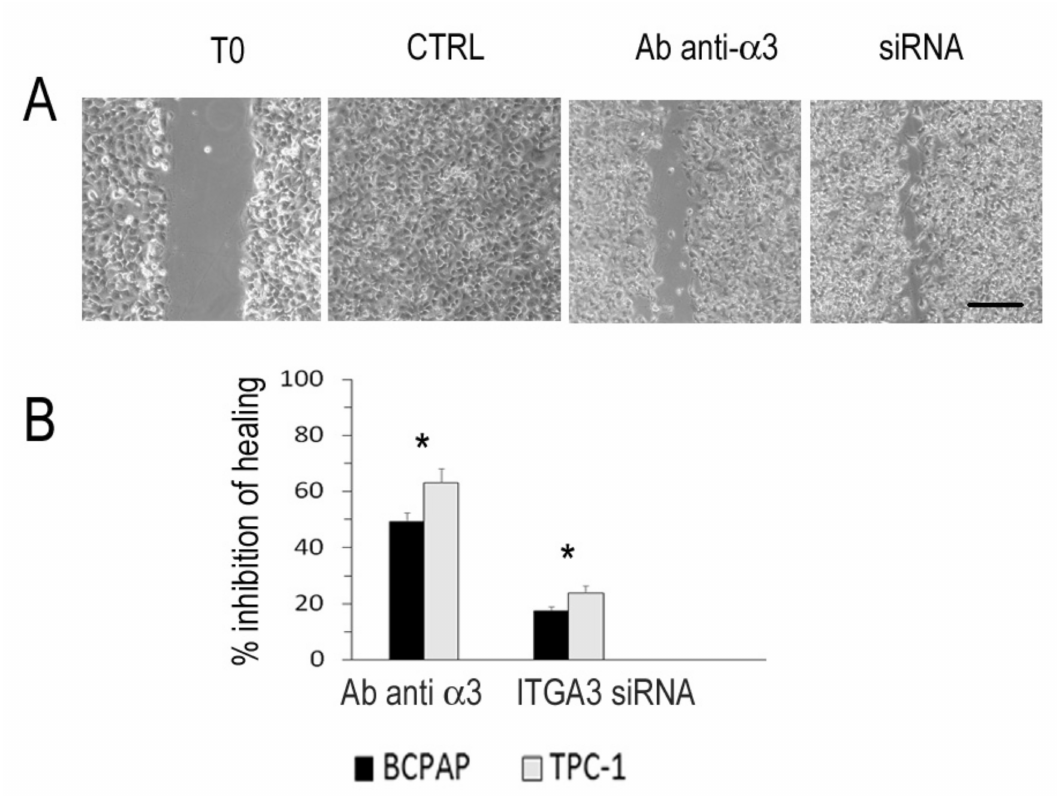
Figure 6. Scratch assay. BCPAP ( A ) and TPC-1 cells were plated in ECM coated wells, a scratch was produced (T0), and the healing process was photographed after 24 h. The cells were untreated or transfected with scrambled oligos (CTRL), transfected with ITGA3 siRNA duplexes, or incubated with monoclonal antibody anti- α 3 subunit (Ab anti- α 3). Scale bar, 200 µ m. Magnification × 200. ( B ) Hedges distances were measured and reported as percentage of inhibition of healing. Standard deviations of triplicate experiments were <5%. *, p <